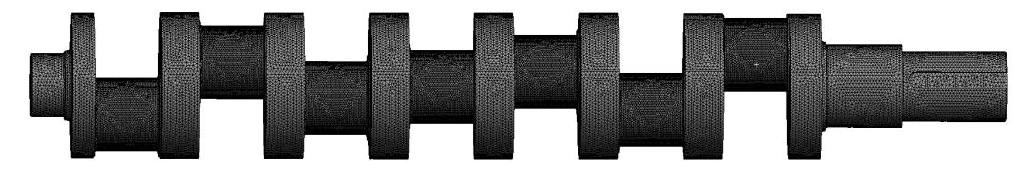
Figure 15. Crankshaft grid mode.